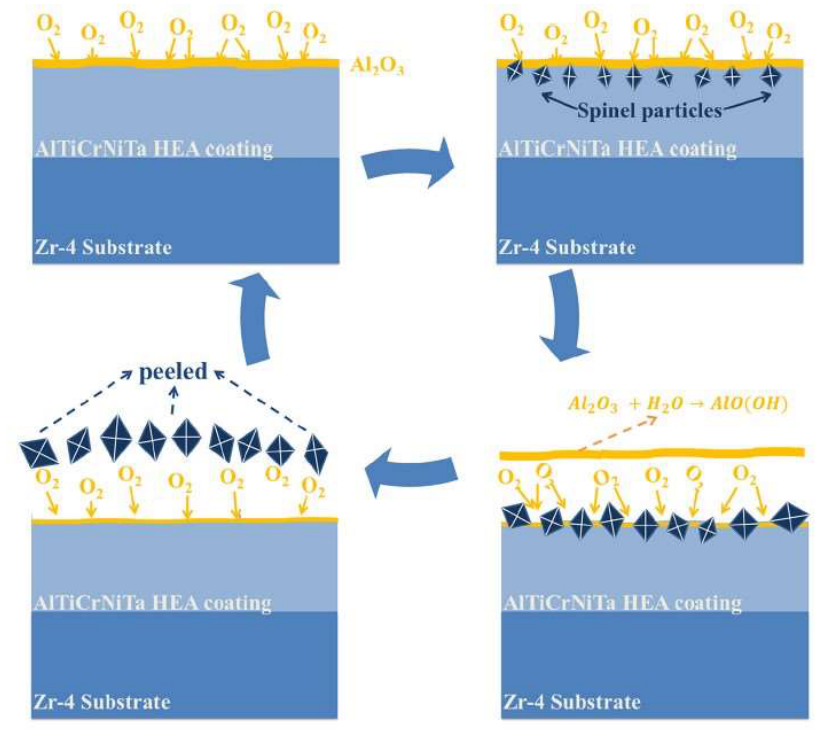
Figure 8. Schematic diagram of oxide peeling off during the corrosion process. Reproduced with permission from [52]. Copyright 2021, Elsevier.